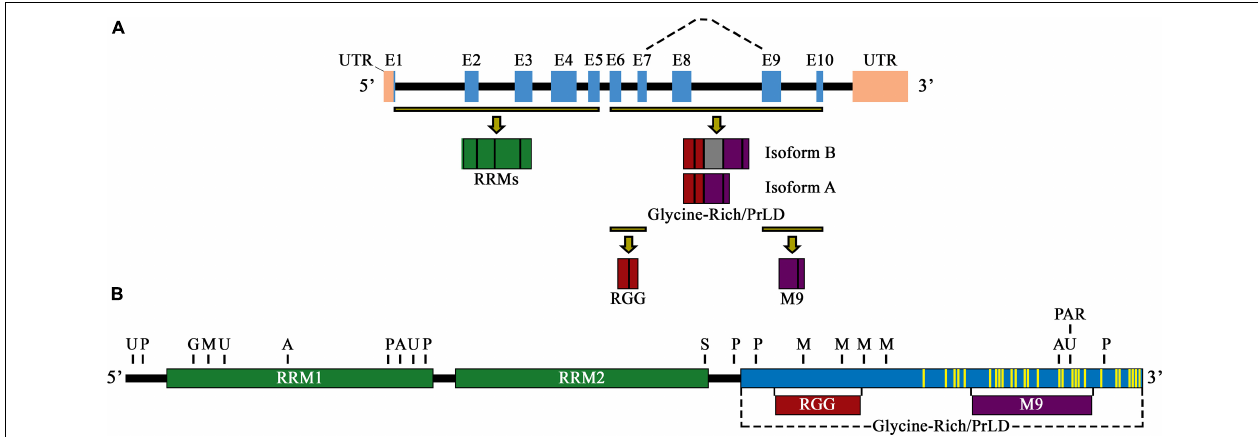
FIGURE 1 | (A) Schematic illustration of the primary pre-mRNA transcript and alternative mRNA splicing of hnRNP A1. Exons are labeled E1–E10 and are highlighted by blue boxes. Black boxes indicate introns, and pink boxes are UTRs. Highlighted exon fractions (yellow-black lines) that form the N-terminal and C-terminal regions of hnRNP A1 are illustrated in green (RRM1 and RRM2) and a combination of red (RGG domain) and purple (M9 sequence), forming the glycine-rich/PrLD domain, respectively. The dashed line represents the main spliced region of hnRNP A1, with inclusion of E8 (gray box) constituting isoform B, and its exclusion constituting isoform A. (B) Schematic illustration of the primary protein structure and functional domains of hnRNP A1 isoform A. RRM1 and RRM1 are signified by green boxes, and the glycine-rich/PrLD domain by a blue box. Highlighted protein fractions that form the RGG domain (red box) and the M9 sequence (purple box) are noted and are in the glycine-rich/PrLD domain relative to their placement underneath. PTM sites of ubiquitination (U), phosphorylation (P), O-GlcNAcylation (G), acetylation (A), sumoylation (S), methylation (M), and PARylation (PAR) are noted above the protein illustration (selectively representative; refer to Table 1 for full list of PTM locations).Yellow lines delineate mutations sites found in hnRNP A1 that have been published and are associated with the neurodegenerative diseases ALS/FTLD and